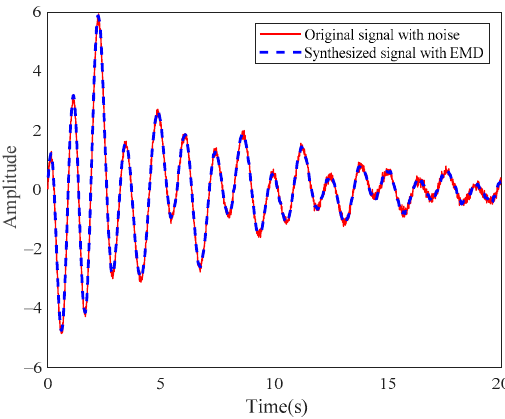
Figure 6. Comparison of the synthesized signal by EMD with signal A.